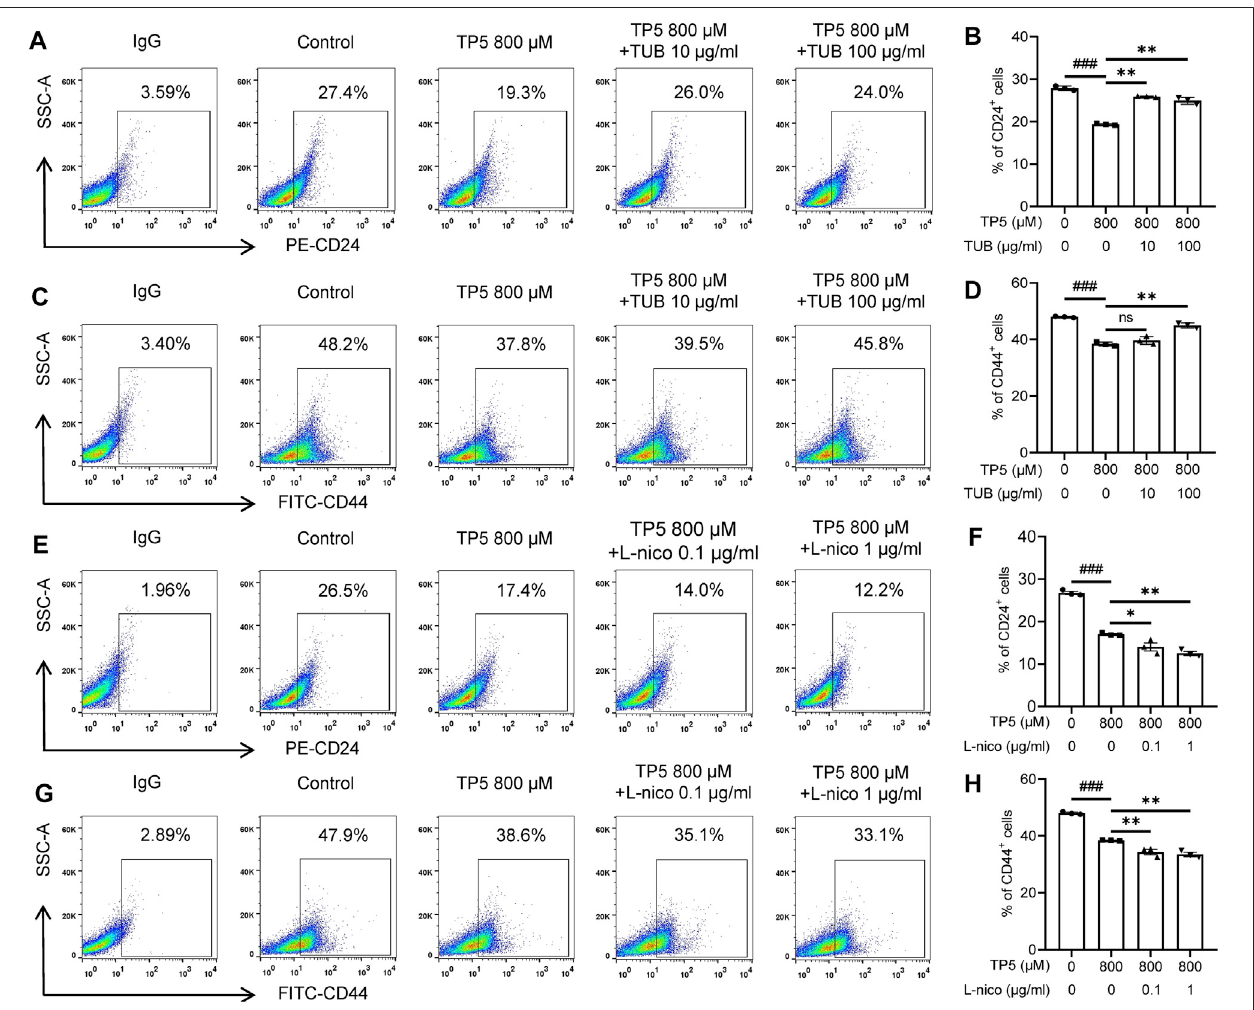
FIGURE 8 | TP5 inhibits HCT116 cancer stem cells via acetylcholine receptors (AchRs). (A – D) Flow cytometric analysis of CSC surface markers CD24 (A, B) and CD44 (C, D) in HCT116 cells treated with TP5-conjugated AchR inhibitor D-Tubocurarine (TUB). (E – H) Flow cytometric analysis of CSC surface markers CD24 (E, F) andCD44 (G,H) inHCT116cellstreatedwithTP5-conjugatedAchRagonistL-nicotine(L-Nico).Dataarerepresentedasmean±SDofthreeindependentexperiments; * p < 0.05,** p < 0.01and*** p < 0.001,one-wayANOVAwithTukey ’ sposthoctest, (A) ,F(3,8)=158.6, p < 0.0001, (B) ,F(3,8)=71.08, p < 0.0001, (C) ,F(3,8)= 123.9, p < 0.0001, (D) , F (3, 8) = 120.8, p < 0.0001; ns, not signi fi